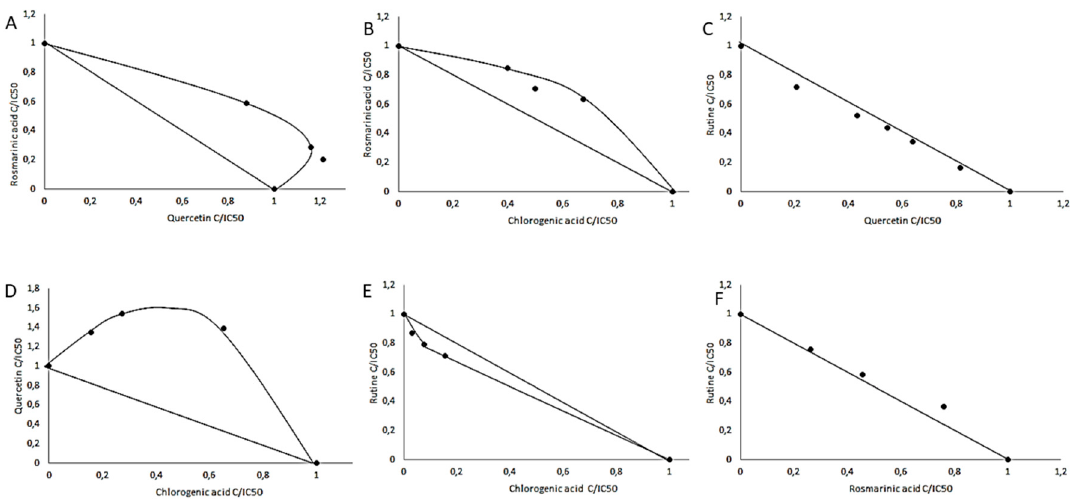
Figure 5. Dose-normalized isobolograms for chosen polyphenols with TPO inhibitory activity.